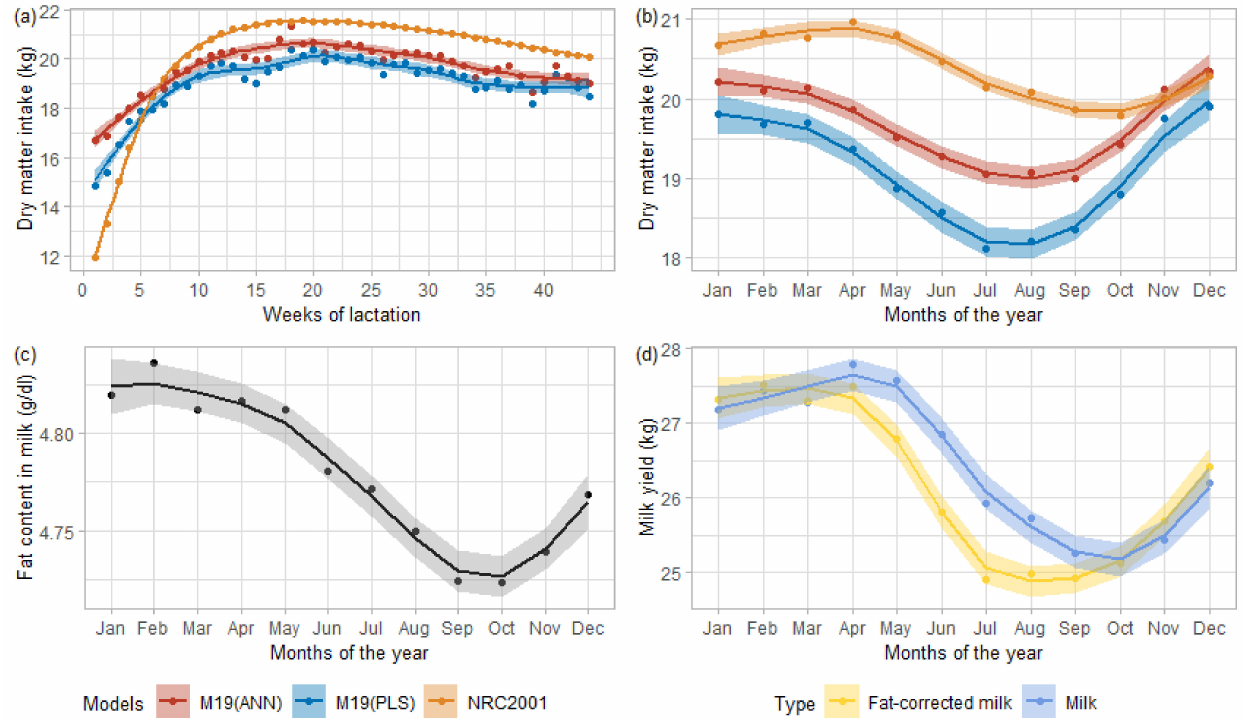
Figure 3. Evolution of the predicted dry matter intake for Walloon Holstein cows with ( a ) lactation and ( b ) year. Predictions related to partial least square regression model M19 in blue and artificial neural network M19 in red. Evolution of ( c ) predicted fat content in milk and ( d ) milk yield and 4% fat corrected milk yield with